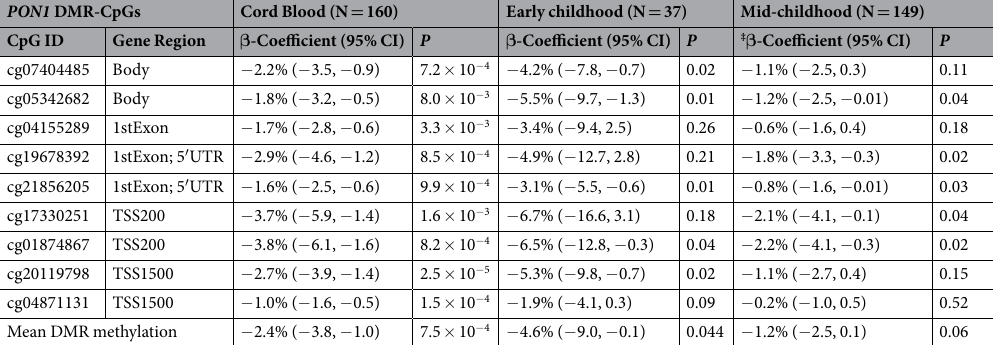
PON1 DMR - CpGs Cord Blood (N = 160) Early childhood (N = 37) Mid-childhood (N = 149)